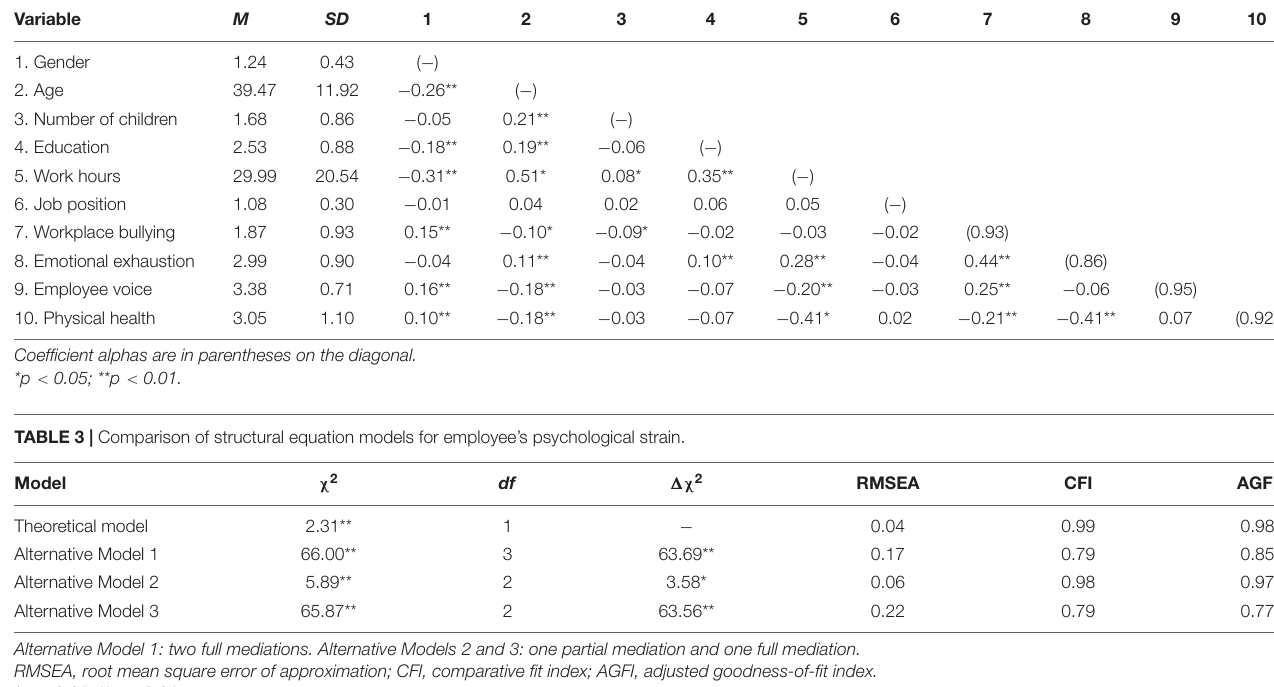
Alternative Model 1: two full mediations. Alternative Models 2 and 3: one partial mediation and one full mediation. RMSEA, root mean square error of approximation; CFI, comparative fit index; AGFI, adjusted goodness-of-fit index. *p < 0.05; **p <